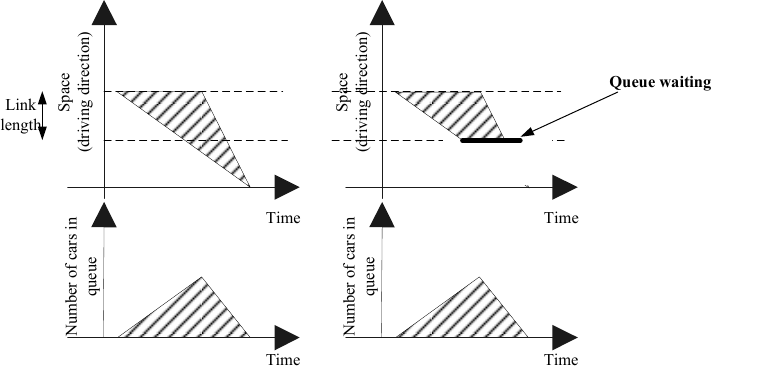
Figure 2. Congestion dynamics in a space-time plane. From left to right: a) realistic queue development, including spillback, b) implementation of a non-spillback